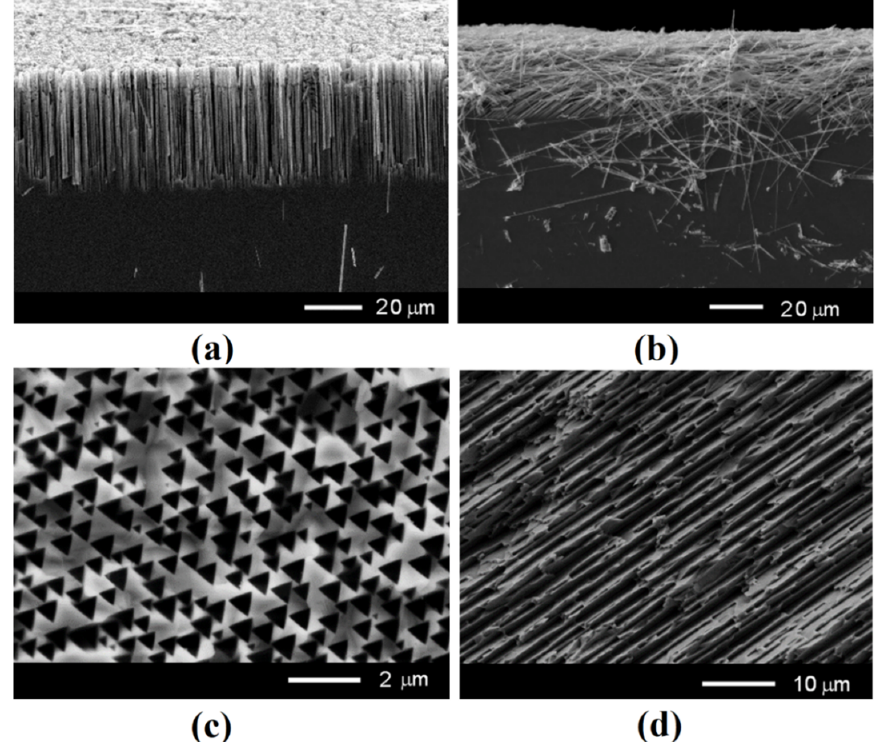
Figure 2. Cross-sectional view of SEM images taken from GaAs nanowires produced on (111)B ( a ) and (001) ( b ) substrates compared with top view SEM images of pores grown in anodized GaAs substrates with (111)B ( c ) and (001) ( d ) orientation.